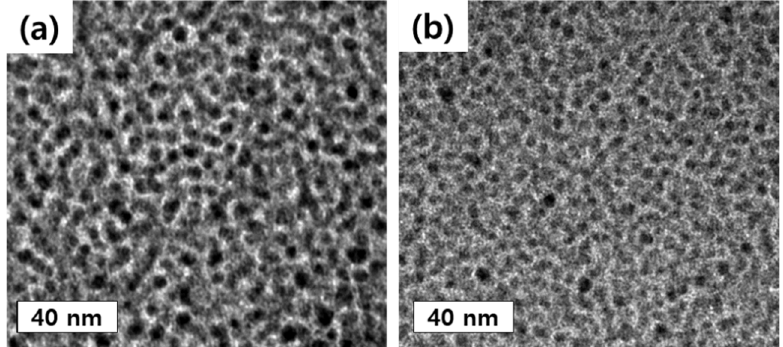
Figure 6. TEM images of solidified-state Nafion ionomers; ( a ) MD220, ( b ) ND140.